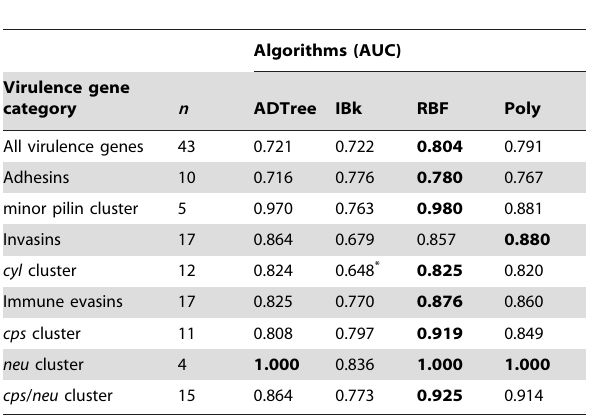
Table 2. Performance of algorithms (area under ROC curve, AUC) in the rediscovery experiment using only NEM316 genome.